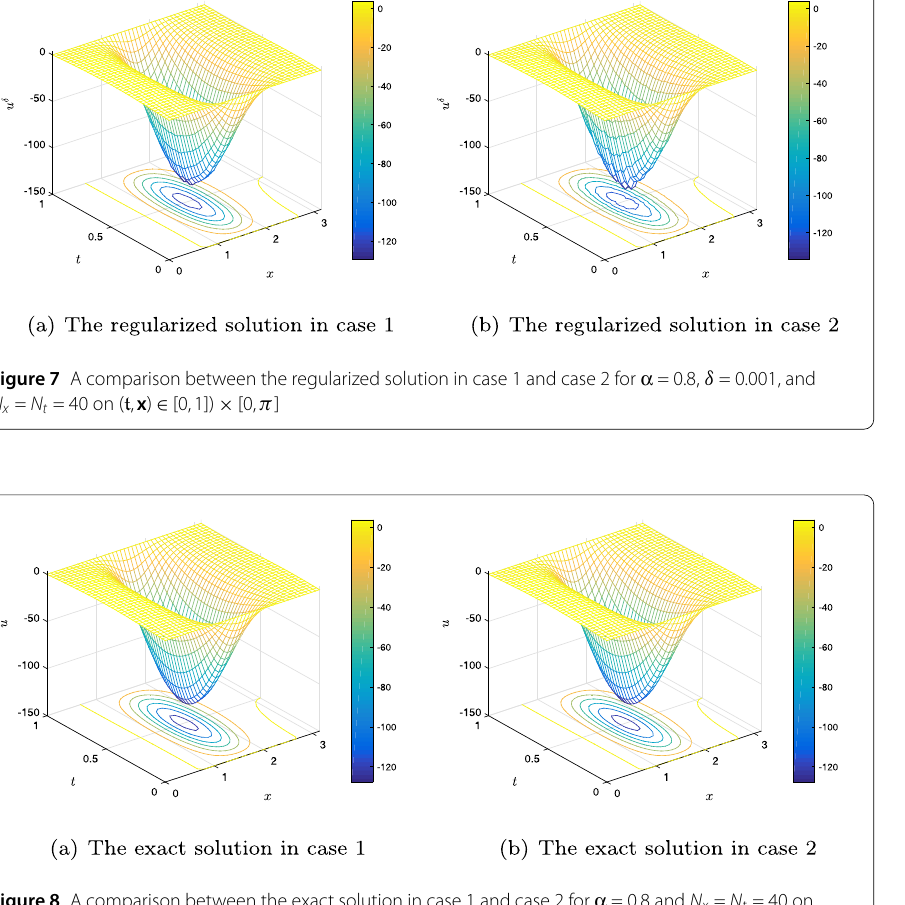
Figure 8 A comparison between the exact solution in case 1 and case 2 for α = 0.8 and N x = N t = 40 on ( t , x ) ∈ [0,1]) × [0, π